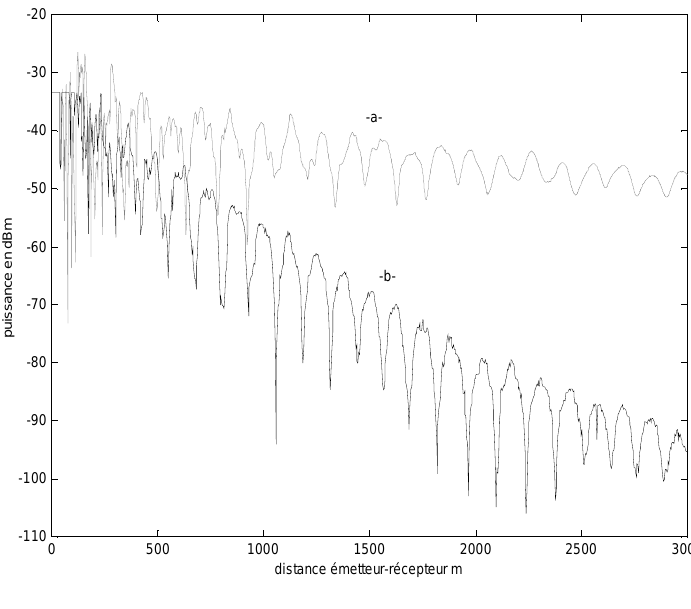
Figure 1. Variation of the received power, expressed in dBm, versus distance. Comparison between theory (a) and experiments